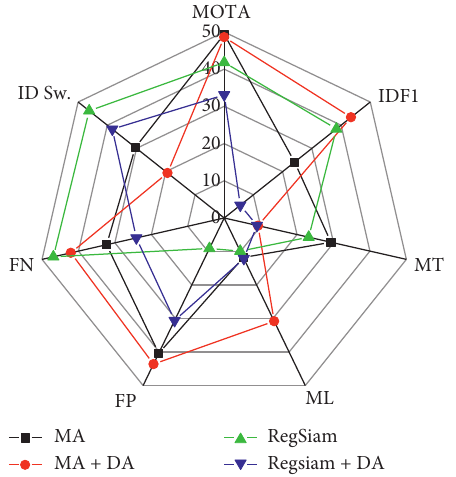
Figure 3: Effect of multitarget tracking data enhancement on tracking performance. Figure